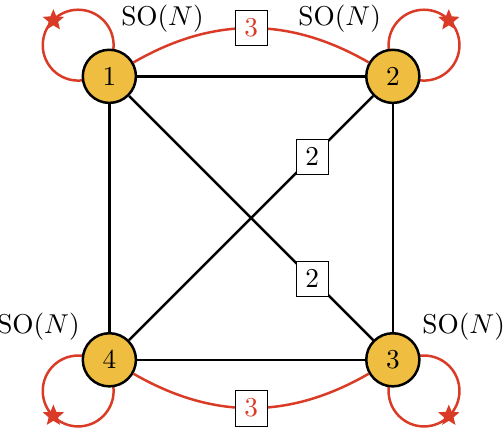
Figure 11 . Quiver diagram for the Spin(7) orientifold of phase B of H 4 using the universal involution.